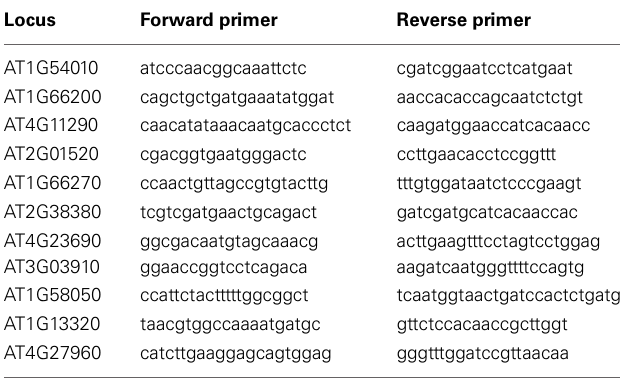
Table 2 | Primers used to quantify gene expression. Locus